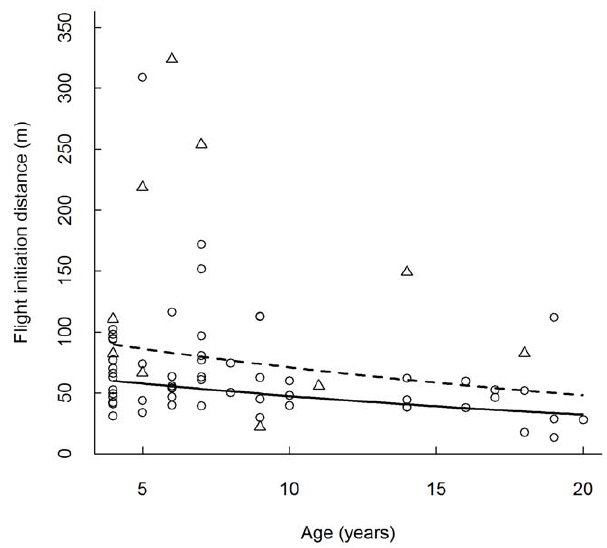
Figure 2. Flight initiation distance (FID) in relation to age of the bear. Distribution of flight initiation distance (FID) for passive (circles and full line) and active (triangles and broken line) Scandinavian brown bears approached by humans on foot in central Sweden in 2006–2009 (n=78), in relation to the age of the bear.